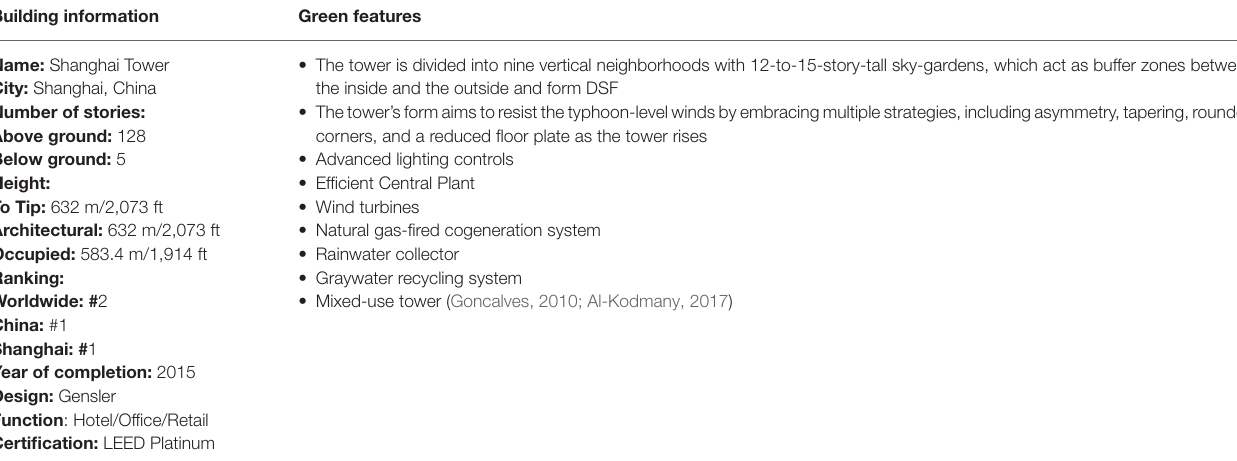
TABLE 9 | Shanghai Tower: Key green features. Building information